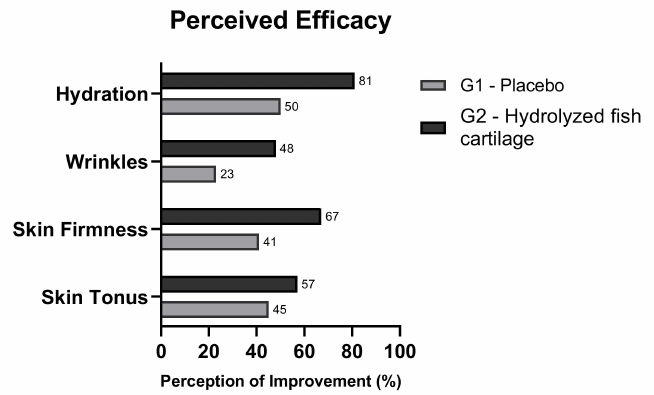
Figure 9. Perceived efficacy after both supplementations in terms of skin tonus, skin firmness, improvement of wrinkles, and hydration. The results are reported as relative frequency of categorical